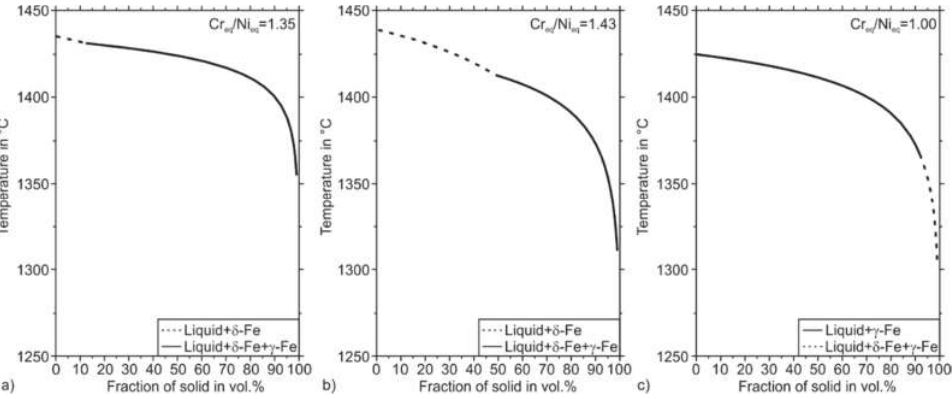
Figure 10. Solidification paths calculated using the Scheil–Gulliver approach; ( a ) A-PBF, ( b ) B-PBF, ( c ) C-PBF.